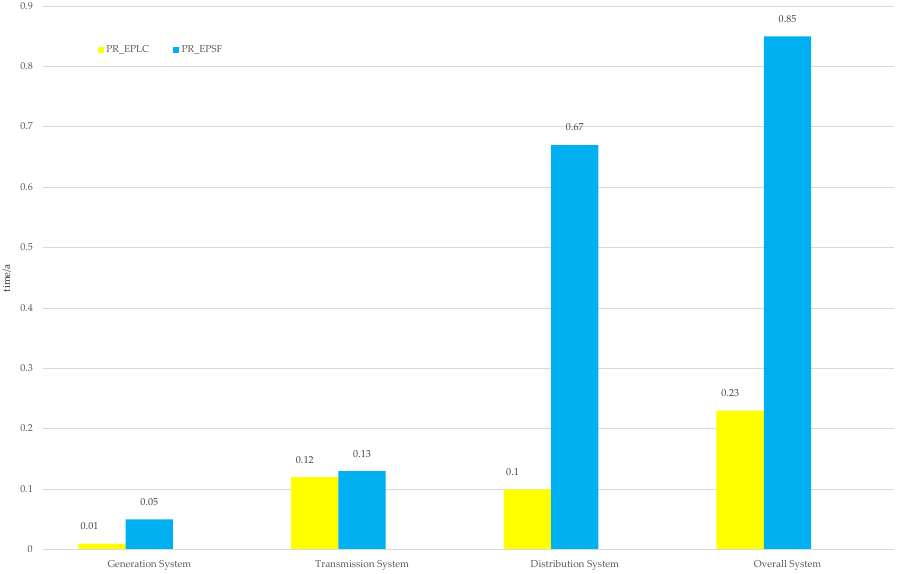
Table 8. Subsystem load shedding index.